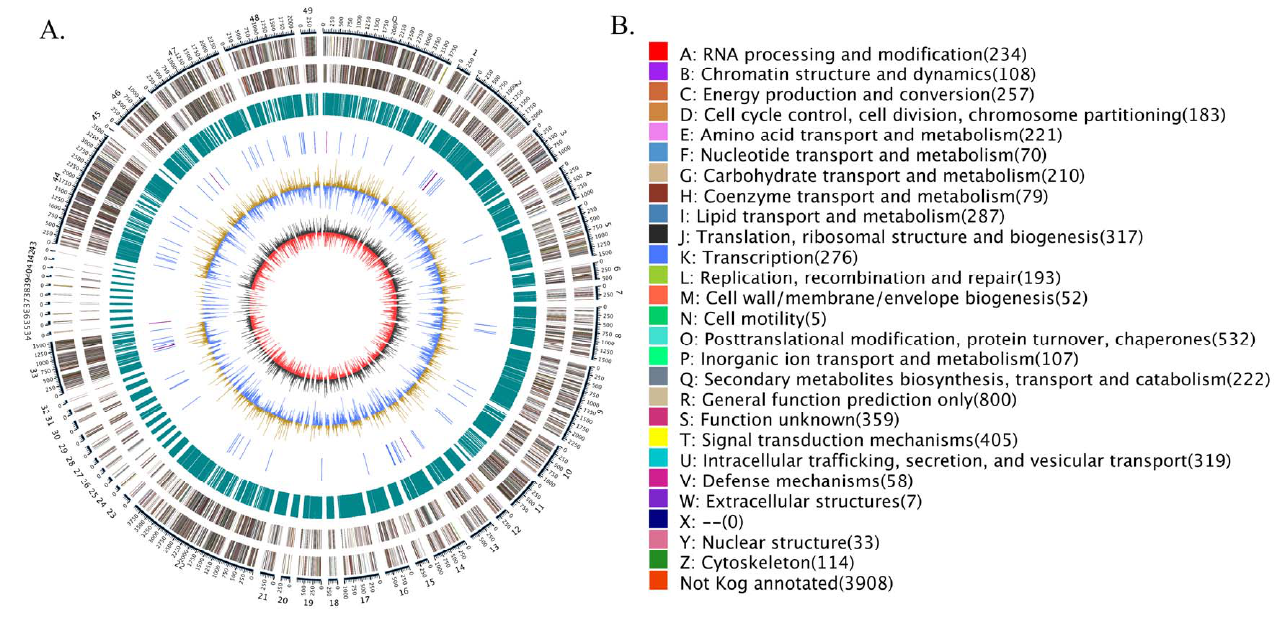
Figure 4. The G. purpuraceus circular genome diagram. ( A ) The circular genome diagram. ( B ) The KOG functional classification in circular diagram.